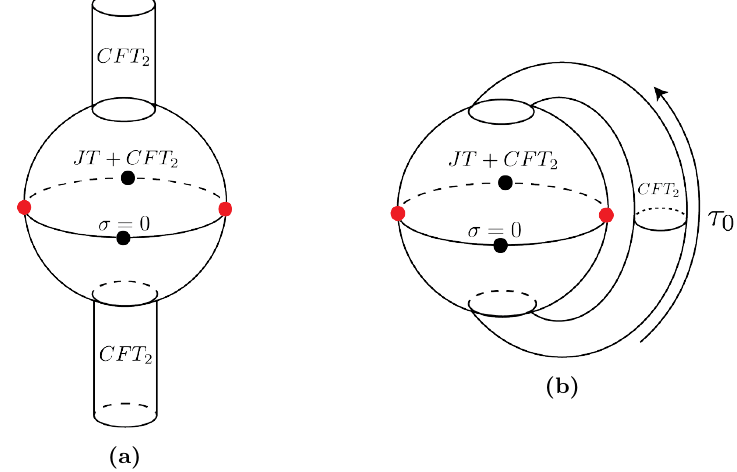
Figure 16. In the figure on the left, we imagine attaching two semi-infinite cylinders to holes at the north and south poles of the sphere. Here we have exaggerated the size of the holes relative to the size of the sphere. This prepares the CFT matter state in the vacuum on the circle, as was considered in section 2. On the right, we imagine making the CFT state thermal. This will raise the energy in the spacetime and make the wormholes longer upon analytic continuation. The red dots denote points of maximal dilaton and the black dots denote points of minimal dilaton along the σ = 0 time